Question: What visual encoding does this figure use to show its data?
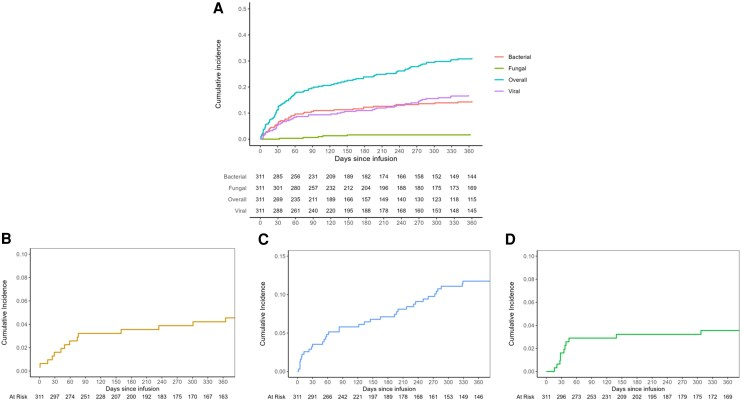
Answer: line